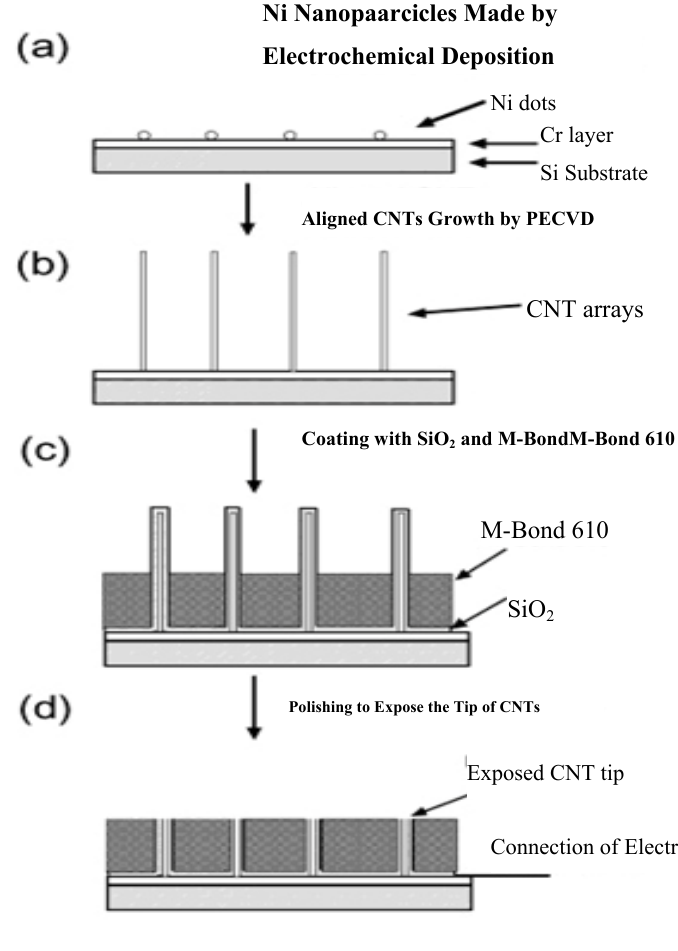
Figure 2. Fabrication scheme of the NEAs. ( a ) Ni nanoparticles electrodeposition; ( b ) aligned carbon nanotube growth; ( c ) coating of SiO expose CNTs. Reprinted with permission from